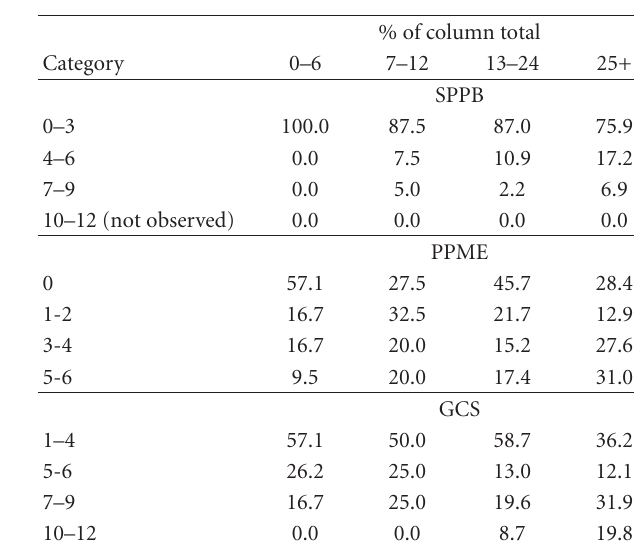
Table 3: Distance from mortality (months) by physical perfor- mance